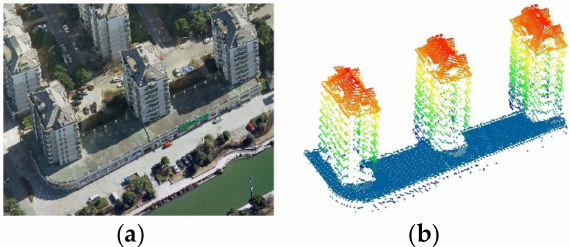
Figure 3. Podium building: ( a ) aerial image corresponding to podium buildings; ( b ) podium building point clouds.